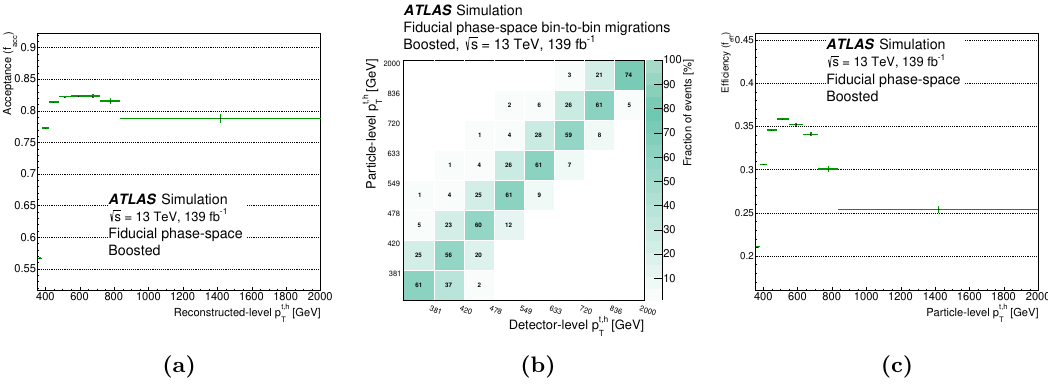
are shown in (a) and (c). The T